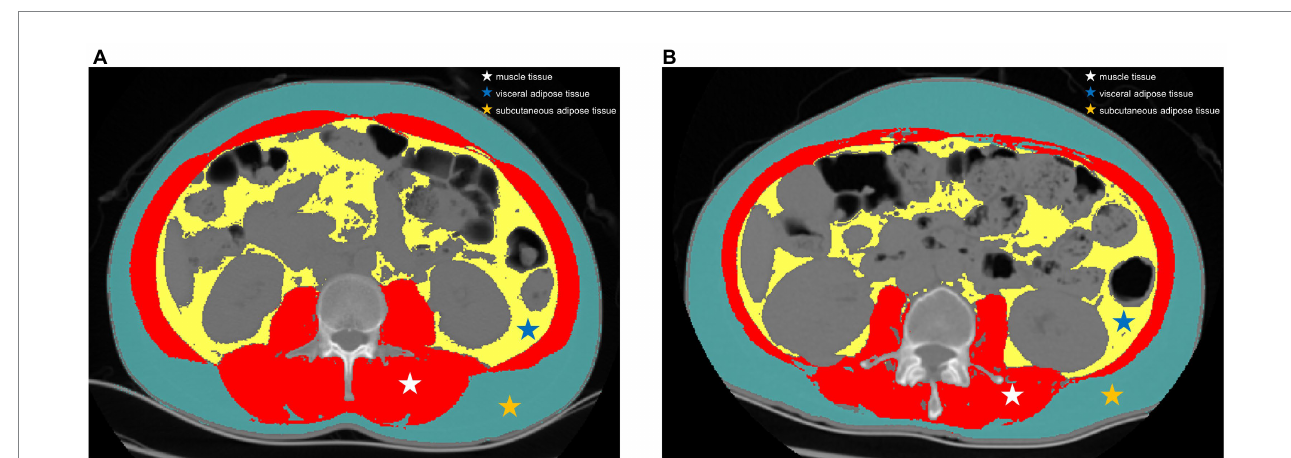
FIGURE 2 Representative computed tomography scans at the third lumbar vertebra level in patients with and without sarcopenia. (A) a patient with high skeletal muscle index and (B) a patient with low skeletal muscle index. Red region: skeletal muscle mass, assessed using thresholds of-29 to 150 Hounsfield units; yellow region: visceral adipose tissue, assessed using thresholds of-150 to-50 Hounsfield units; green region: subcutaneous adipose tissue, assessed using thresholds of − 190 to − 30 Hounsfield